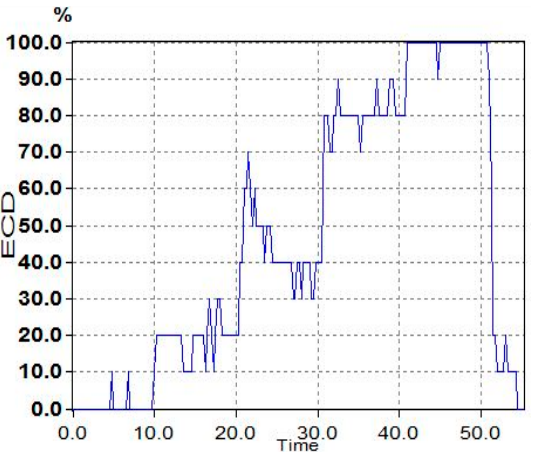
Figure 3. The typical signals for one trial ECD plots.